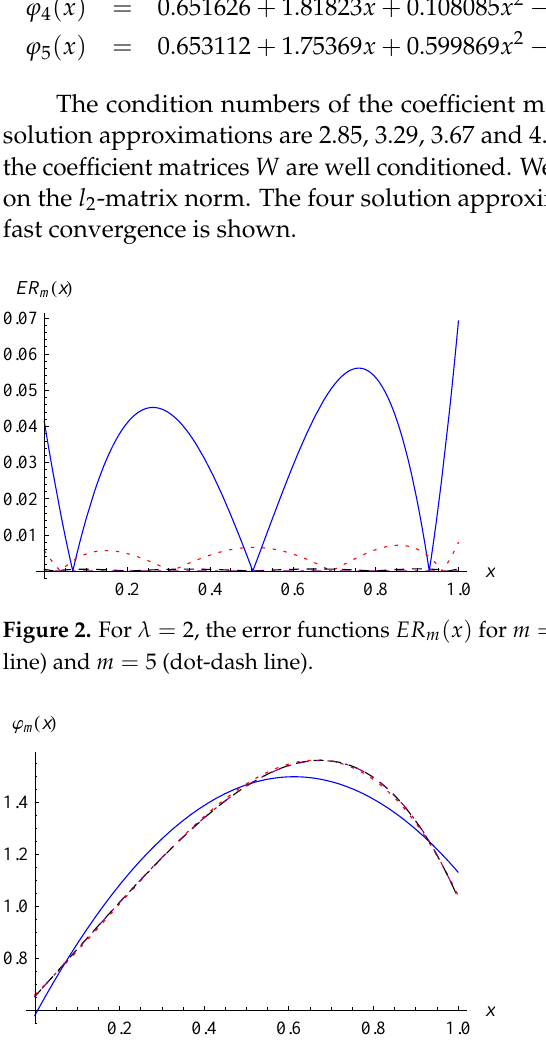
Figure 3. For λ = 1.5, the solution approximations ϕ m ( x ) for m = 2 (solid line), m = 3 (dot line), m = 4 (dash line) and m = 5 (dot-dash